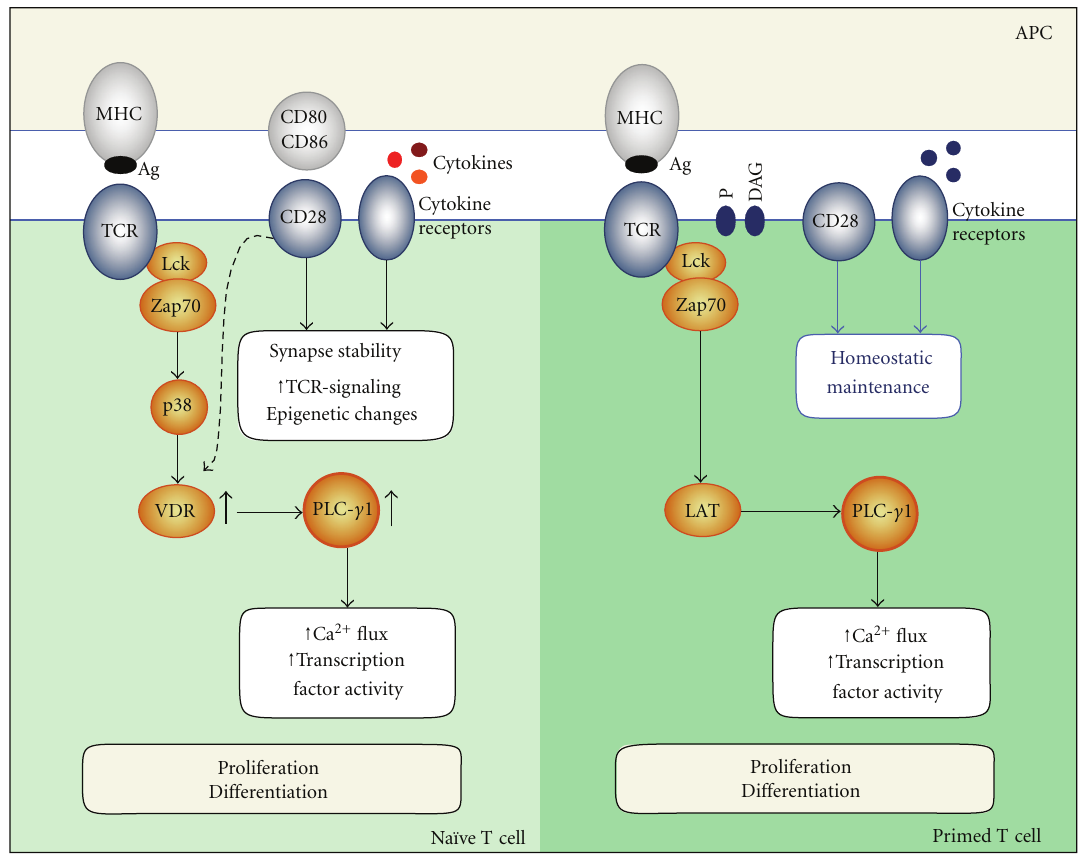
Figure 1: Simplified model illustrating the di ff erences in T-cell signaling between na¨ıve and primed T cells. In na¨ıve human T cells, TCR engagement leads to activation of p38 through Zap70 resulting in upregulation of VDR and then PLC- γ 1 mandatory for the na¨ıve T cells to be activated. For activation, na¨ıve T cells also require CD28 and cytokine receptor signals to induce and stabilize membrane structures and intracellular signaling molecules. In contrast, primed T cells already express PLC- γ 1, have a higher DAG and phosphoprotein (P) basal level in specialized membrane structures with a high association of the CD45 molecule. In addition, signaling in primed T cells is rather independent of CD28 costimulatory signals as well as “third-signal” inflammatory cytokines, overall leading to a far more prompt antigenic